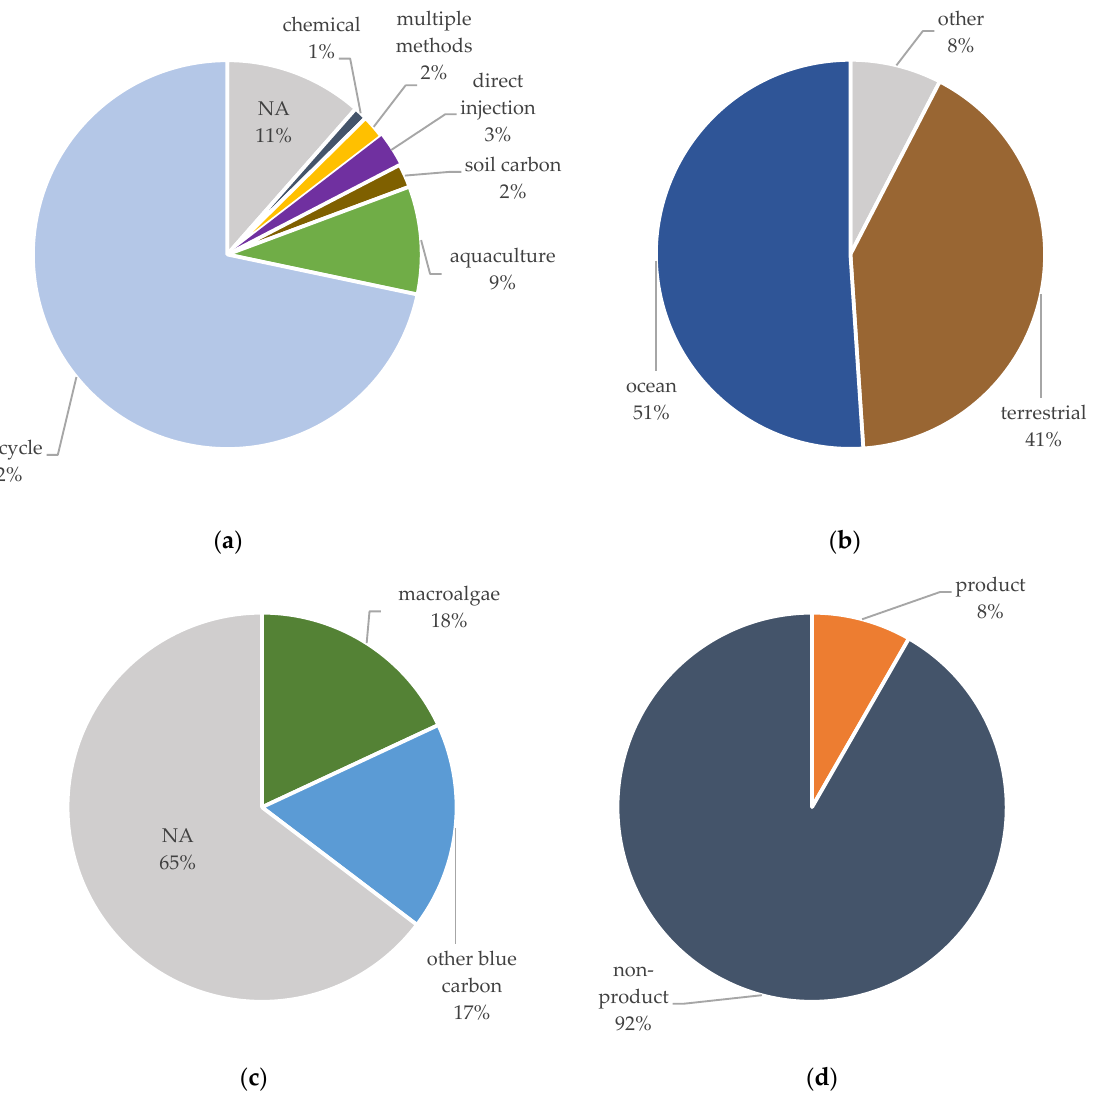
Figure 1. Composition of the papers included in the literature review, n = 382. ( a ) CDR approach referred to in the paper; ( b ) Context, papers categorized by ocean, terrestrial, or other; ( c ) Blue carbon; ( d ) Utilization of carbon into products. NA = Not Applicable.